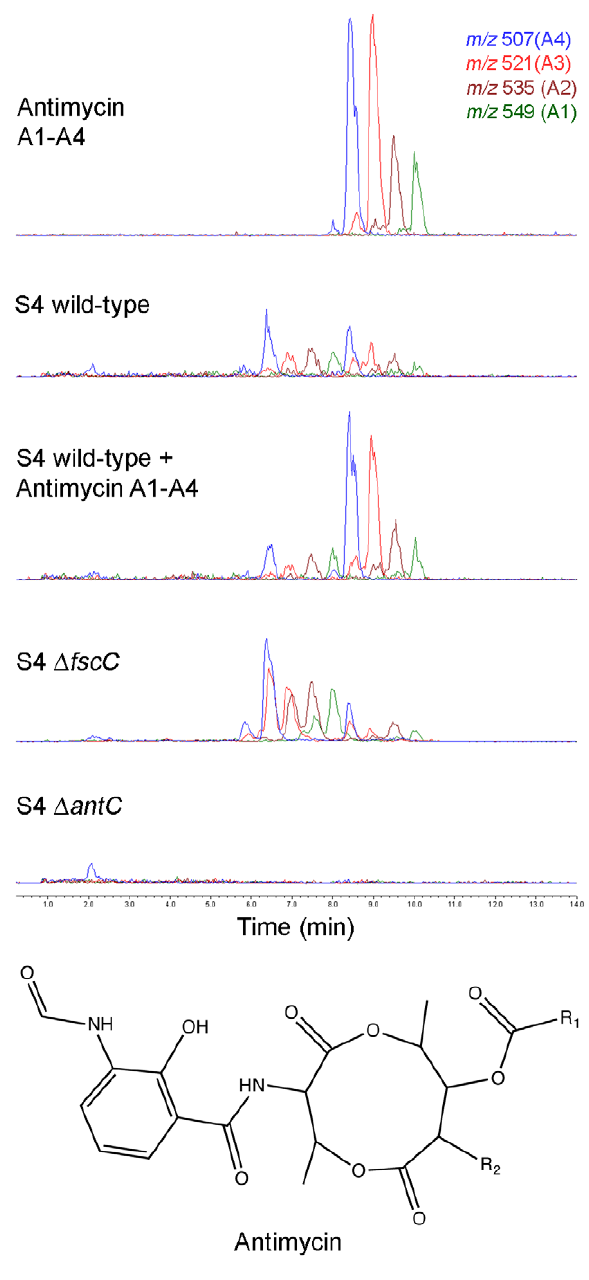
Figure 3. LC/MS analysis of Streptomyces S4 wild-type and mutant strains compared to antimycin standards. The extracted ion chromatograms for antimcyins A1–A4 are shown. Eight compounds consistent with the mass of antimycin A1–A4 were produced by S4 wild-type and S4 D fscC , but were not produced by the D antC mutant. Co-injection of antimycin A1–A4 with the S4 wild-type extract demonstrated that antimycin A1–A4 have the same retention time as four of the eight compounds produced by S4 wild-type. The UV visible spectra and ESI positive mode mass spectra for antimycin A1–A4 and the eight antimycin compounds produced by S4 wild-type are shown in Fig. S1 and Fig. S2, respectively. Antimycin A1: R 1 =CH(CH 3 )CH 2 CH 3 , R 2 =(CH 2 ) 5 CH 3 . Antimycin A2: R 1 =CH(CH 3 ) 2 , R 2 =(CH 2 ) 5 CH 3 . Antimycin A3: R 1 =CH(CH 3 )CH 2 CH 3 , R 2 =(CH 2 ) 3 CH 3 . Antimycin A4: R1=CH(CH 3 ) 2 R 2 =(CH 2 ) 3 CH 3 .